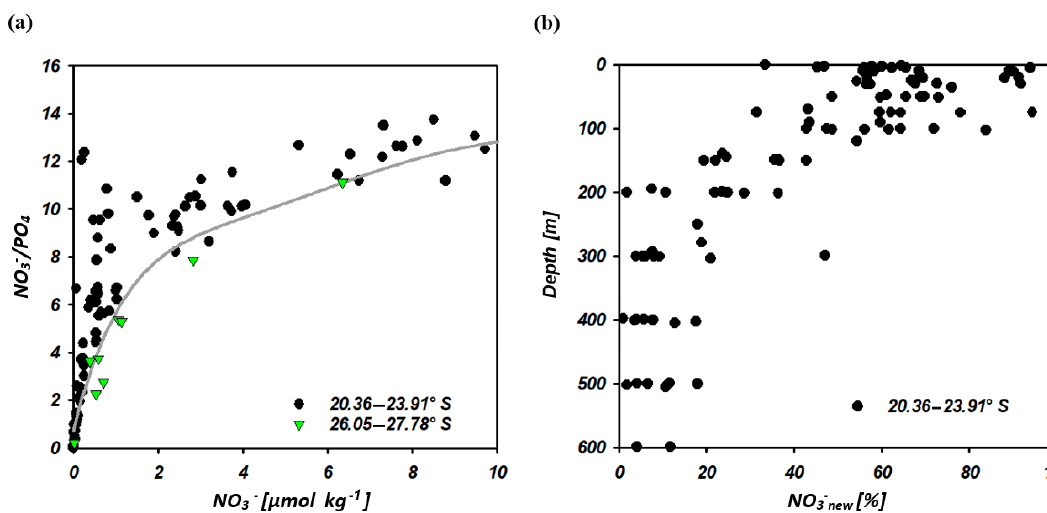
/ PO 3 − Figure 10. NO − ratio vs. nitrate concentrations of seawater samples at 20.36–23.91 ◦ S and 26.05–27.78 ◦ S (a) . The solid grey line 3 4 / PO 3 − / PO 3 − indicates the calculated N assimilation (NO − vs. NO − ) with a preformed NO − ratio of 13.25 for the region of 3 cal 3 4 cal 3 4 in the IOSG and 14.25 for the southern equatorial Indian Ocean in addition to progressive nutrient assimilation with a Redfield ratio of 16 / PO 3 − ) vs. depth at latitudes between 20.36 and ). In (b) we present the portion of nitrate formed out of newly fixed N (NO − (NO − 3 new 3 4 ass 23.91 ◦